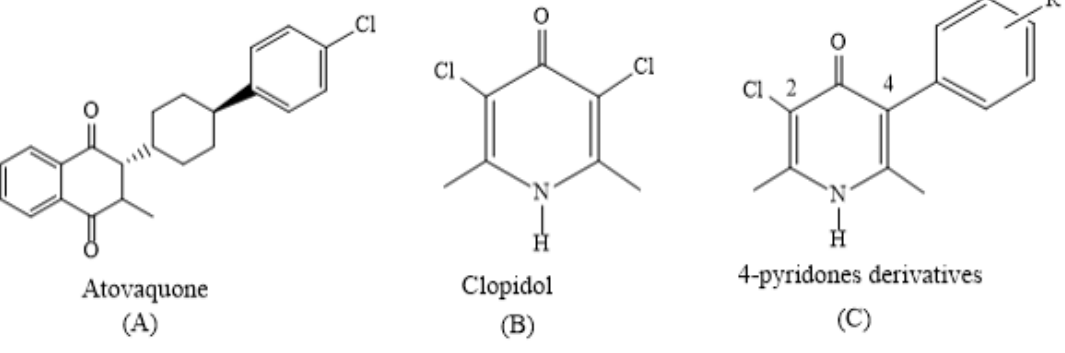
Figure 1. Chemical Structures of antimalarial compounds used in this work. ( A ): Atovaquone; ( B ): Clopidol, C: structural bases of 4-Pyridones derivatives study in this work. Numbering in ( C ) is arbitrary.